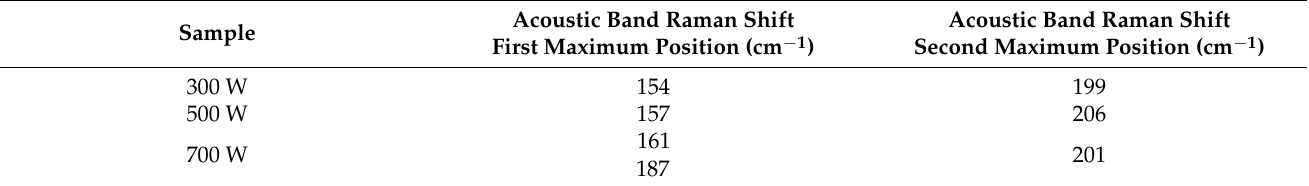
Table 2. Acoustic band splitting of different samples after